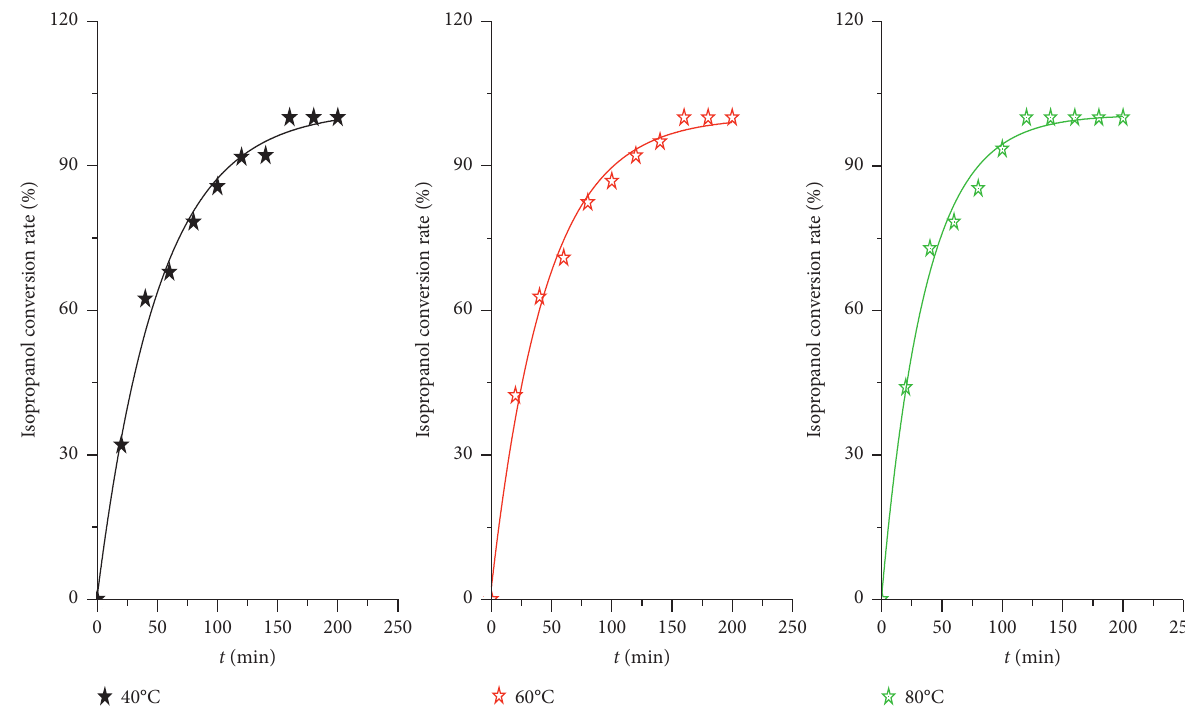
Figure 5: Rate of isopropanol transformation in terms of the presence of ZnO.